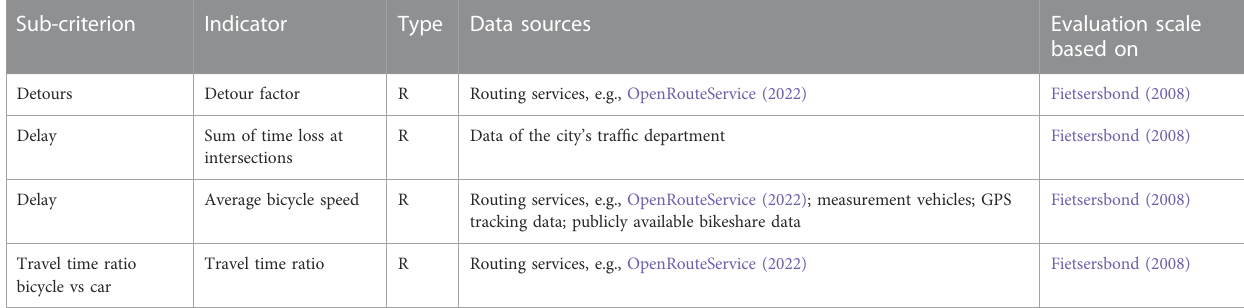
TABLE 4 Directness: sub-criteria, indicators, type of indicators (E: edge-based, R: route-based, N: network-based), data sources and sources for evaluation scales.